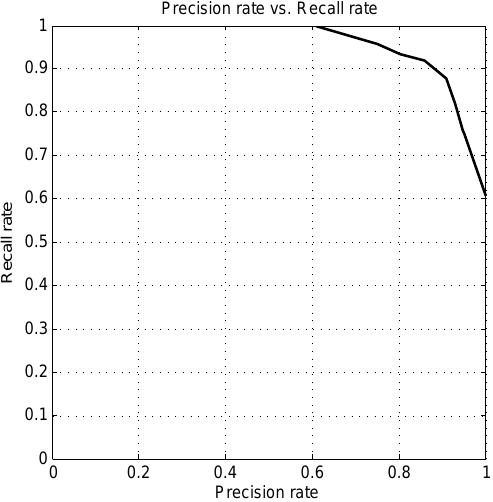
Figure 8. Detection precision-recall curve on